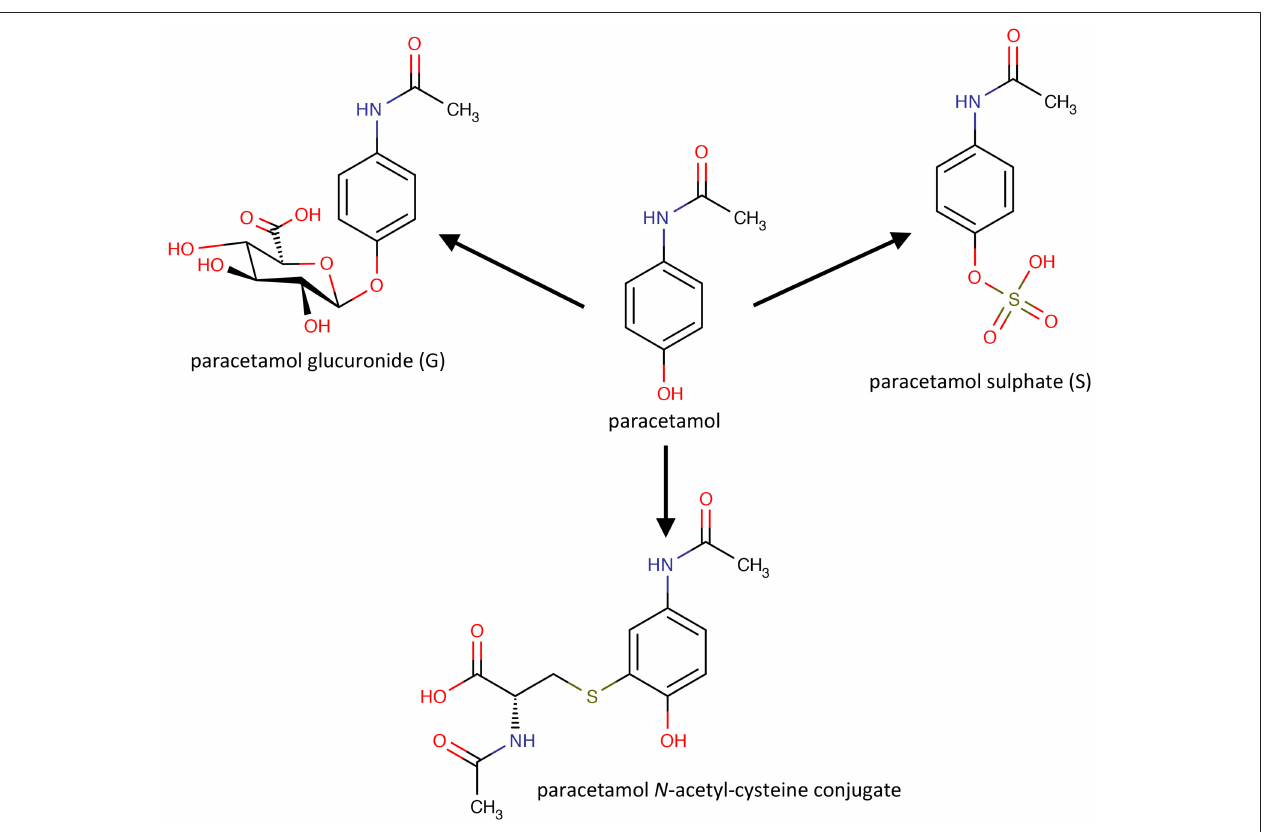
FIGURE 2 | The molecular structures of paracetamol and its principal human